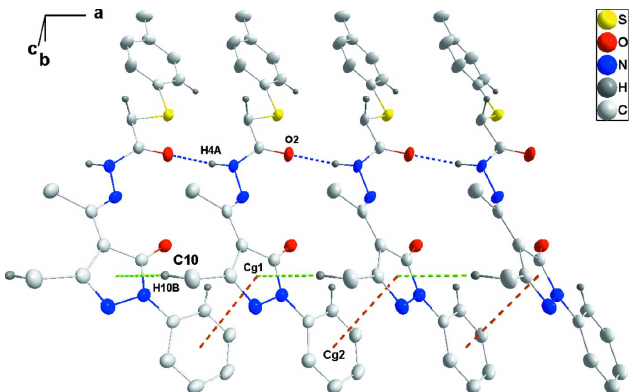
Figure 2 Plan view of the packing, showing the layers formed by intermolecular